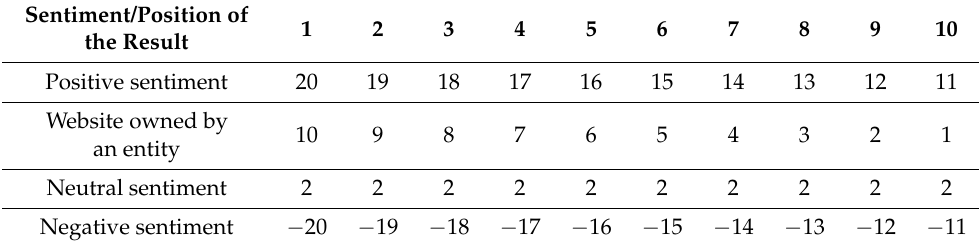
Table 1. Sentiment analysis